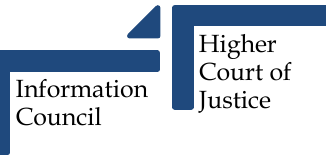
Figure 4: Levels of RTI Appeals in Jordan